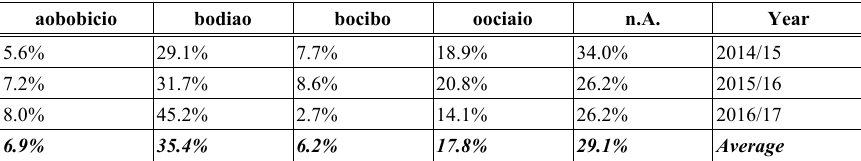
Table 7. Results of the code